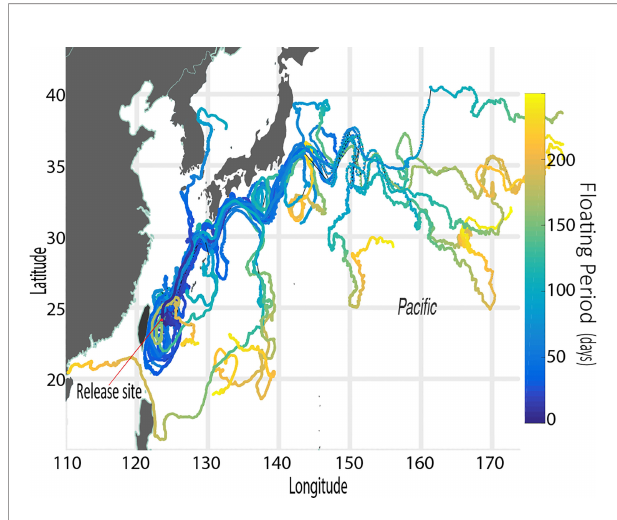
FIGURE 10 | Trajectories of 31 GPS drifting buoys over 250 days are shown. The retention period of buoys in the Ryukyu Archipelago is < 100 days on average and only a few stayed as long as 200 days. The Kuroshio Current is involved in trajectories of particles released from western Iriomote Island. Potential to travel as far as the mid Paci fi c Ocean was con fi rmed. The color bar shows temporal data in days for each position of buoys, and a red point shows the deployment